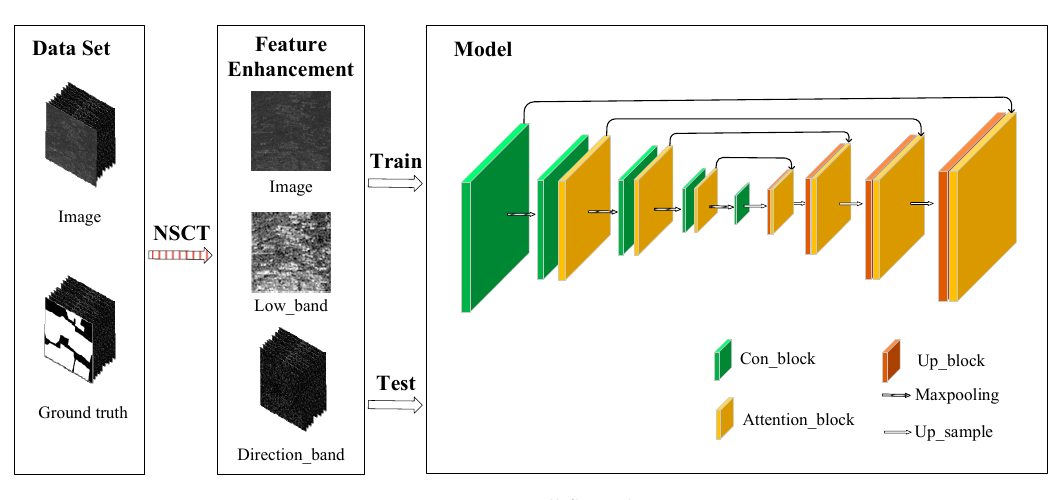
Figure 4. Overall flow chart.